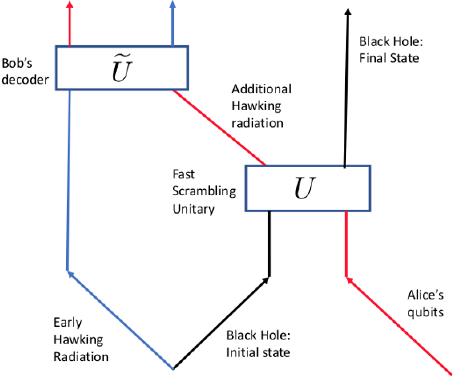
Figure 17 . Diagrammatic representation of the Hayden-Preskill